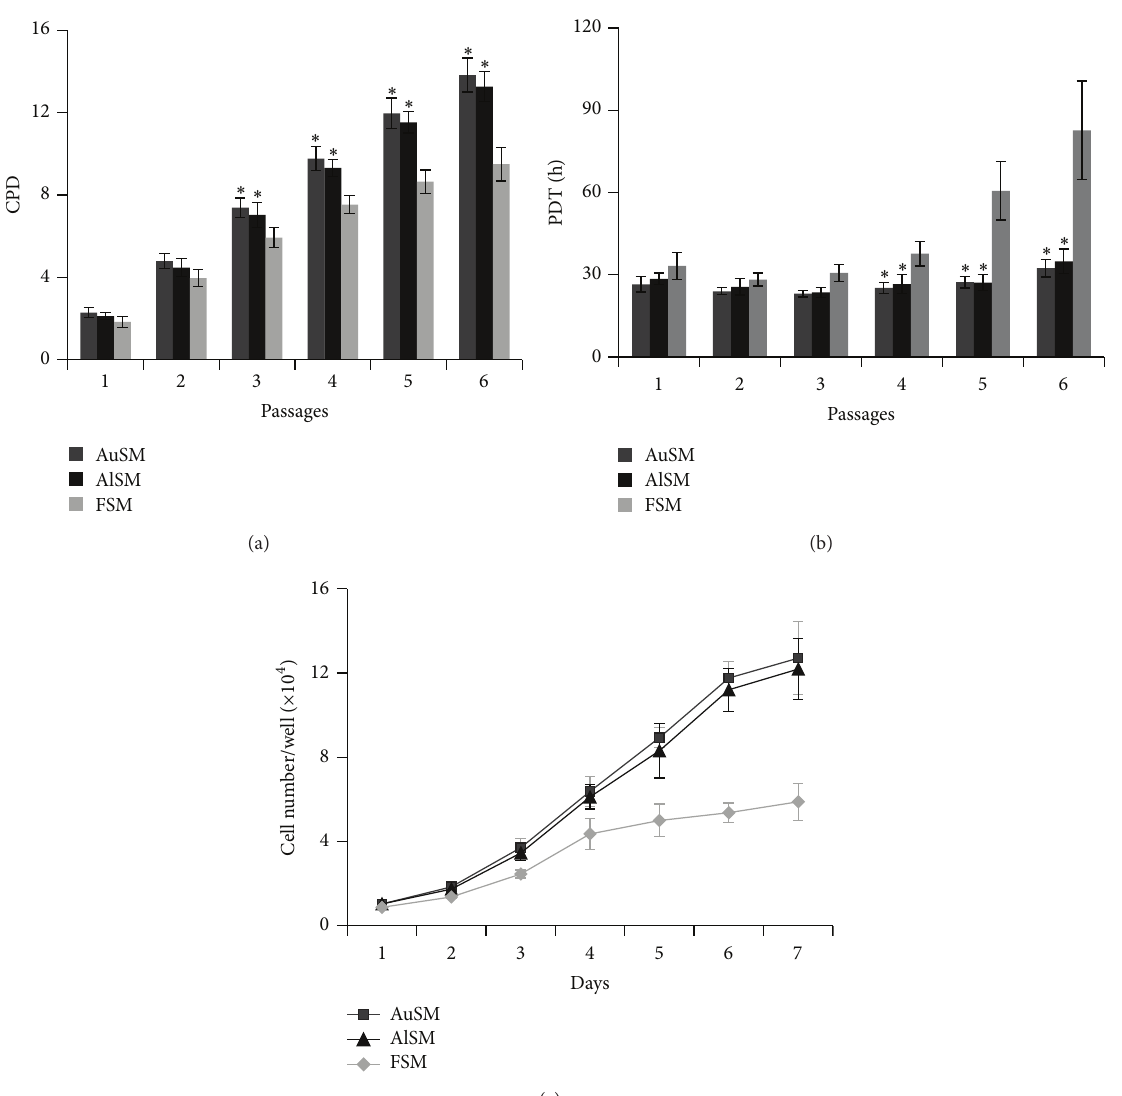
Figure4:ProliferationofBMSCsculturedinAuSM,AlSM,andFSM.(a)MeanCPDforBMSCscultivatedinAuSM,AlSM,andFSM( 𝑛 = 10 ). (b) Mean PDTs for BMSCs incubated in AuSM, AlSM, and FSM ( 𝑛 = 10 ). (c) Growth curves of BMSCs cultured in AuSM, AlSM, and FSM ( 𝑛 = 3 ). ∗ Significantly different from BMSCs cultured in FSM ( 𝑃 < 0.05